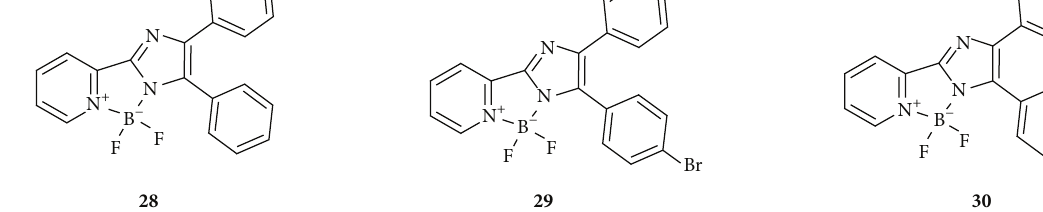
Figure 10: Structures of BODIPY dimers.